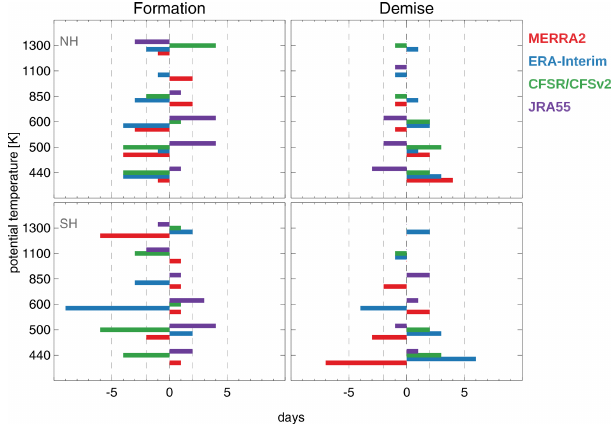
Figure 13. Climatological difference in days between the reanalysis and the REM vortex formation and decay